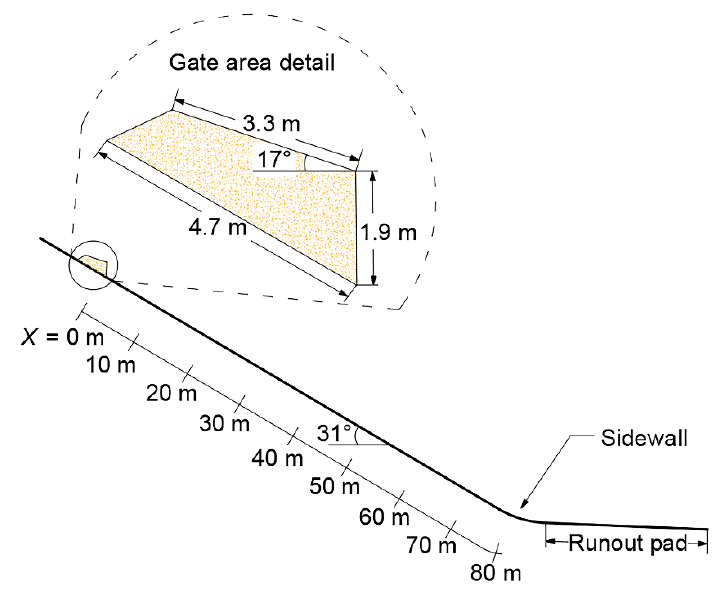
Figure 1. Schematic flume geometry of the debris-flow experiment.